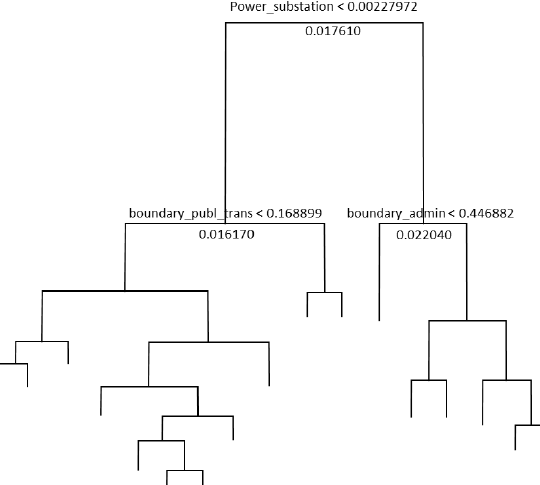
Figure 6. Unemployment regression tree (labels of lower branches removed for reasons of readability)